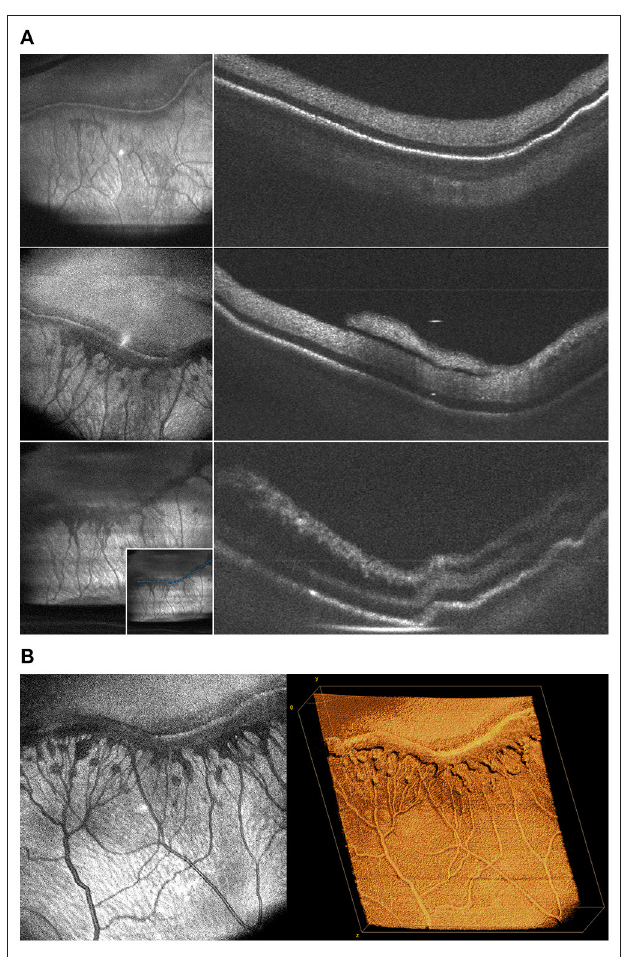
FIGURE 5 | (A) Changes in the morphology of fibrovascular proliferation demonstrated by cross-sectional B-scans taken along the length of the ridgeline every 2 weeks. These images were obtained from a baby born 25 weeks gestation and seen at 36, 39, and 41 weeks postmenstrual age. Left column shows en face projection of peripheral pathology. Right column shows progression of neovascularization and retinal traction on B-scan. The inset in the bottom-left image shows sample manual tracing of the ridgeline B-scan used to generate these cross-sections. (B) Volumetric rendering of ridgeline in stage 3 ROP. This is the same patient as (A) seen at 39 weeks. The image on the left shows an en face view of peripheral fibrovascular proliferation in stage 3 ROP. The image on the right shows three-dimensional rendering of the same volume.